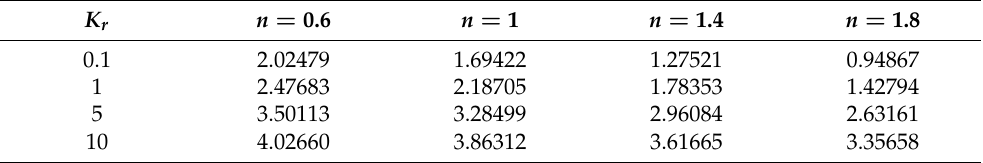
Table 15. The values of the average Nusselt number ( Nu avg ) at the solid-fluid interface. K r n = 0.6 n = 1 n = 1.4 n =